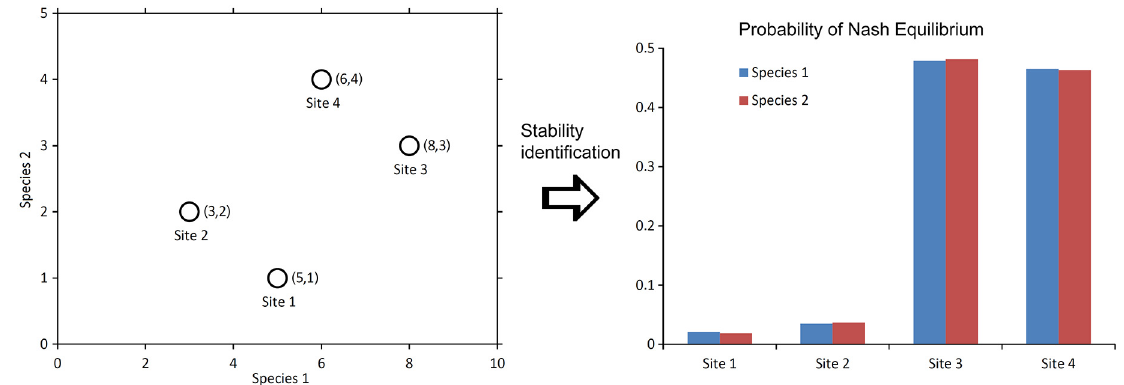
Fig 4. Evaluation of degree of stability expressed as the Nash Equilibrium probability for simple numerical example of two species observed at four sampling sites (mentioned in Chapter 4 of Legendre and Legendre Numerical Ecology